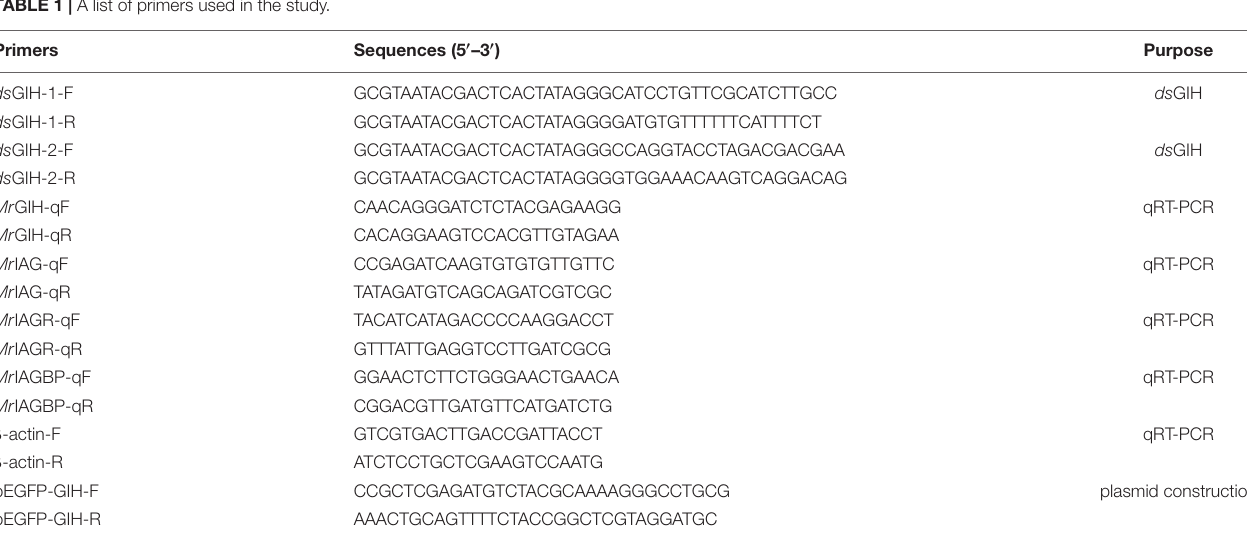
TABLE 1 | A list of primers used in the study.